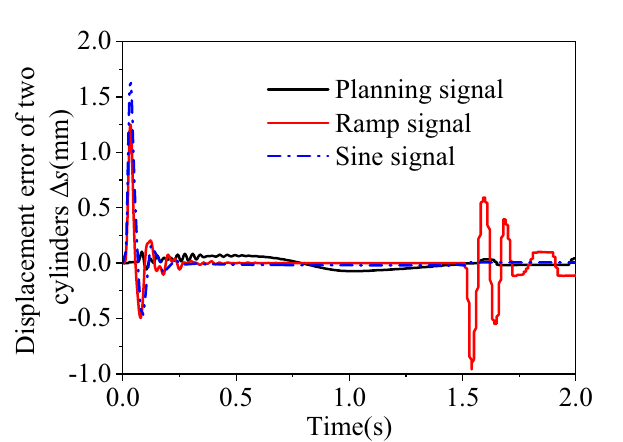
Figure 13. The synchronous error of lifting cylinder.